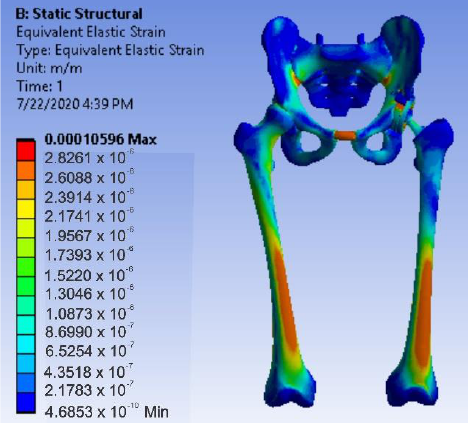
Figure 42. Strain map for revision prosthesis with titanium augment.